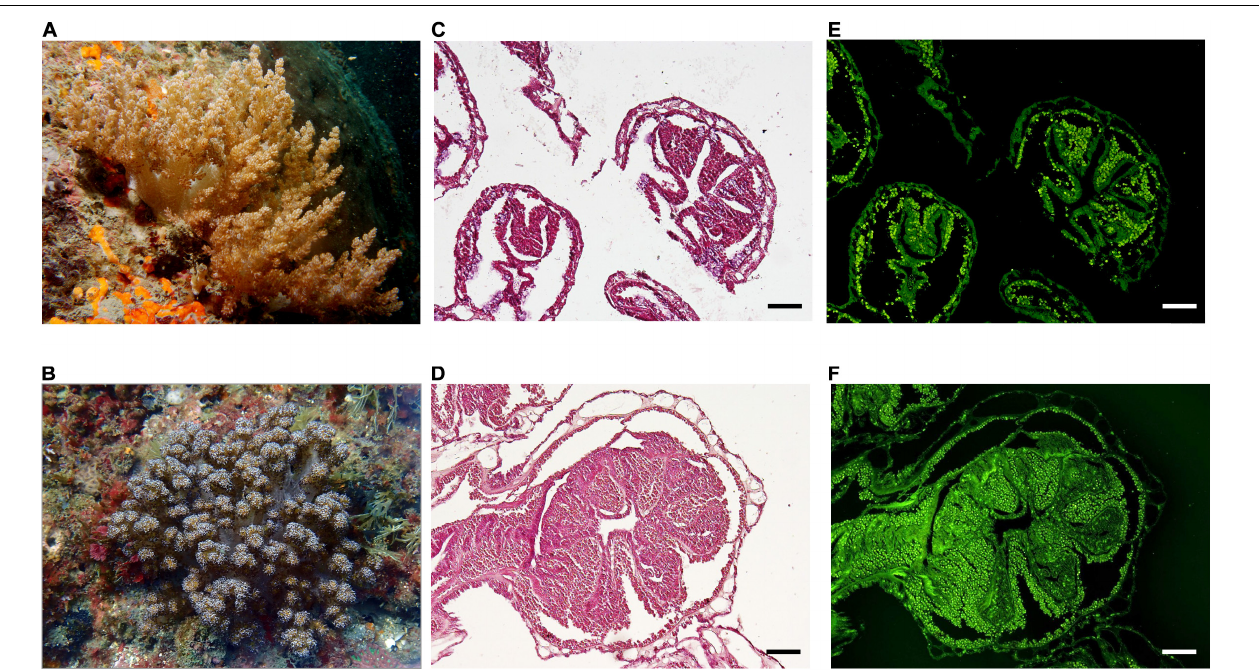
FIGURE 1 | In situ appearance and symbiont distribution in octocoral colonies. Litophyton sp. (A) and Stereonephthya sp. (B) at –10 m depth in Bitou (Taiwan). Histological sections of polyps from Litophyton sp. (C) and Stereonephthya sp. (D) under light microscope with an emphasis on algal endosymbionts using a U-MWB2 filter (E,F) . Scale bar 100 µ